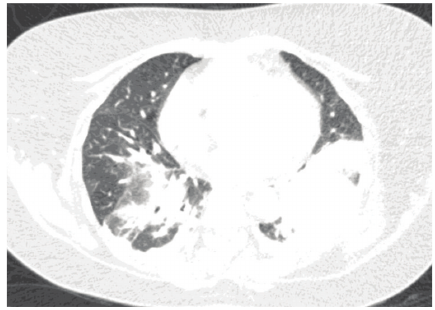
Figure 2: CT chest showing bibasal atelectasis, more prominent on the left.